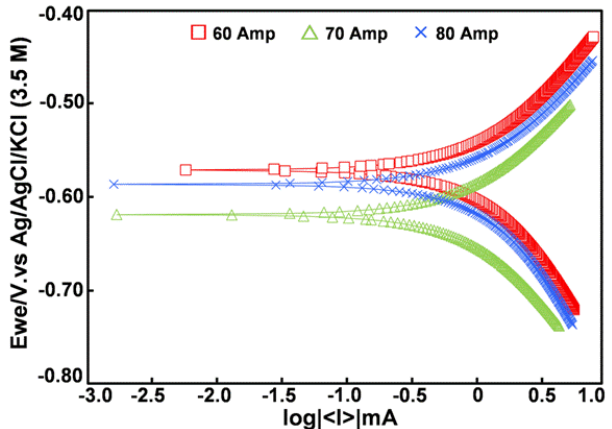
Figure 6. Polarization curve of work-piece welded heat input in welding, and the 0.91 0.95 1.04 kJ/mm with test flow rate at 15 L/min.